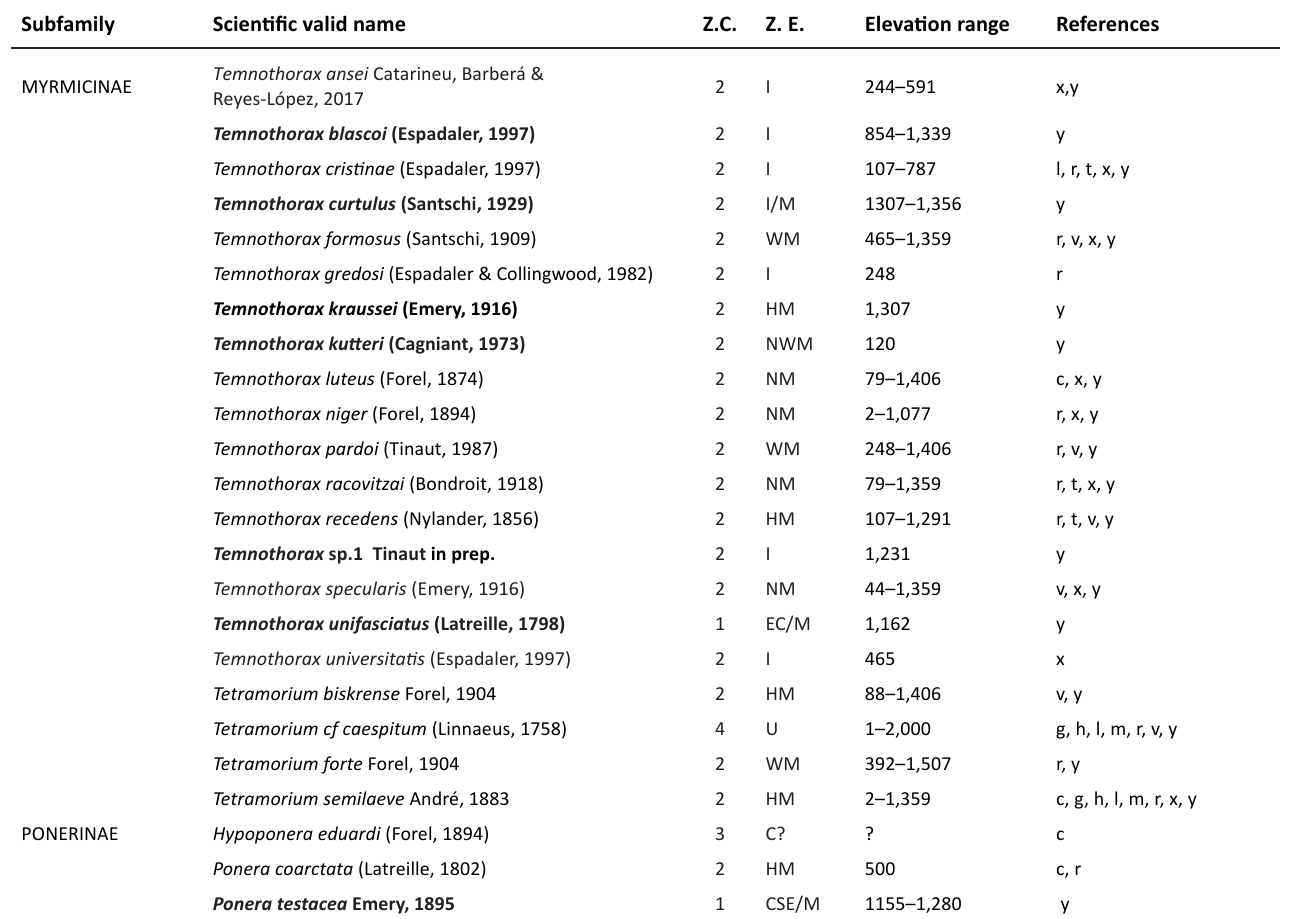
Table 1. Checklist of the ant species of the Segura River Basin. The list is arranged alphabetically by subfamily, genus and species. Species names in bold characters refer to species recorded for the first time in this area. (Continuation)